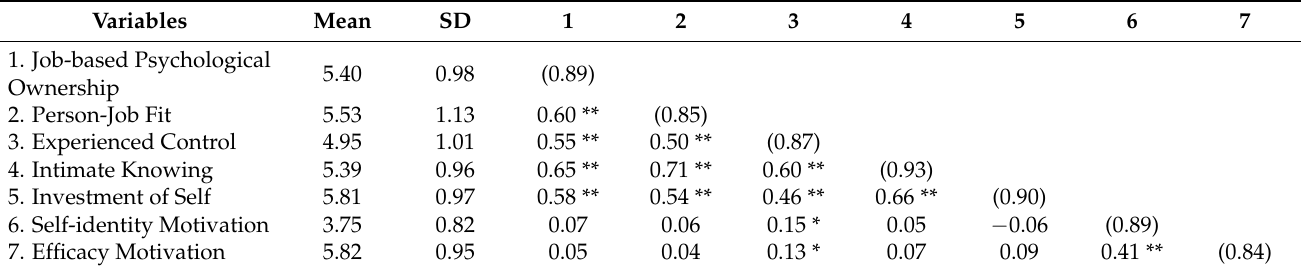
Table 2. Results from tests of direct and interactive hypothesized relationships between person-job fit, routes to psychological ownership, and self-identity and effectance motivations. Variables in Equation